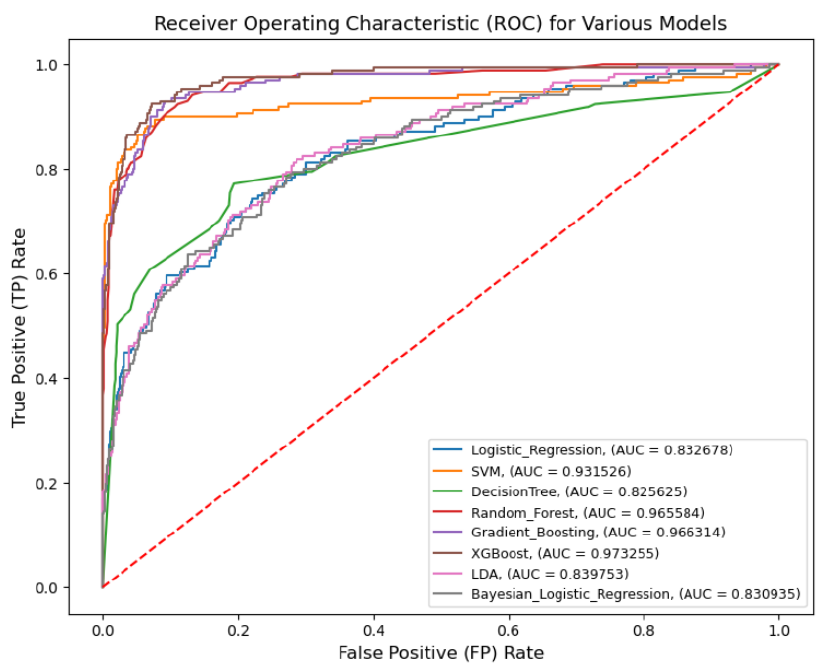
Figure 10. ROC-AUC plot for the classic logistic regression, various machine learning algorithms, and Bayesian (non-informative prior) GLM model. and Bayesian (non-informative prior) GLM